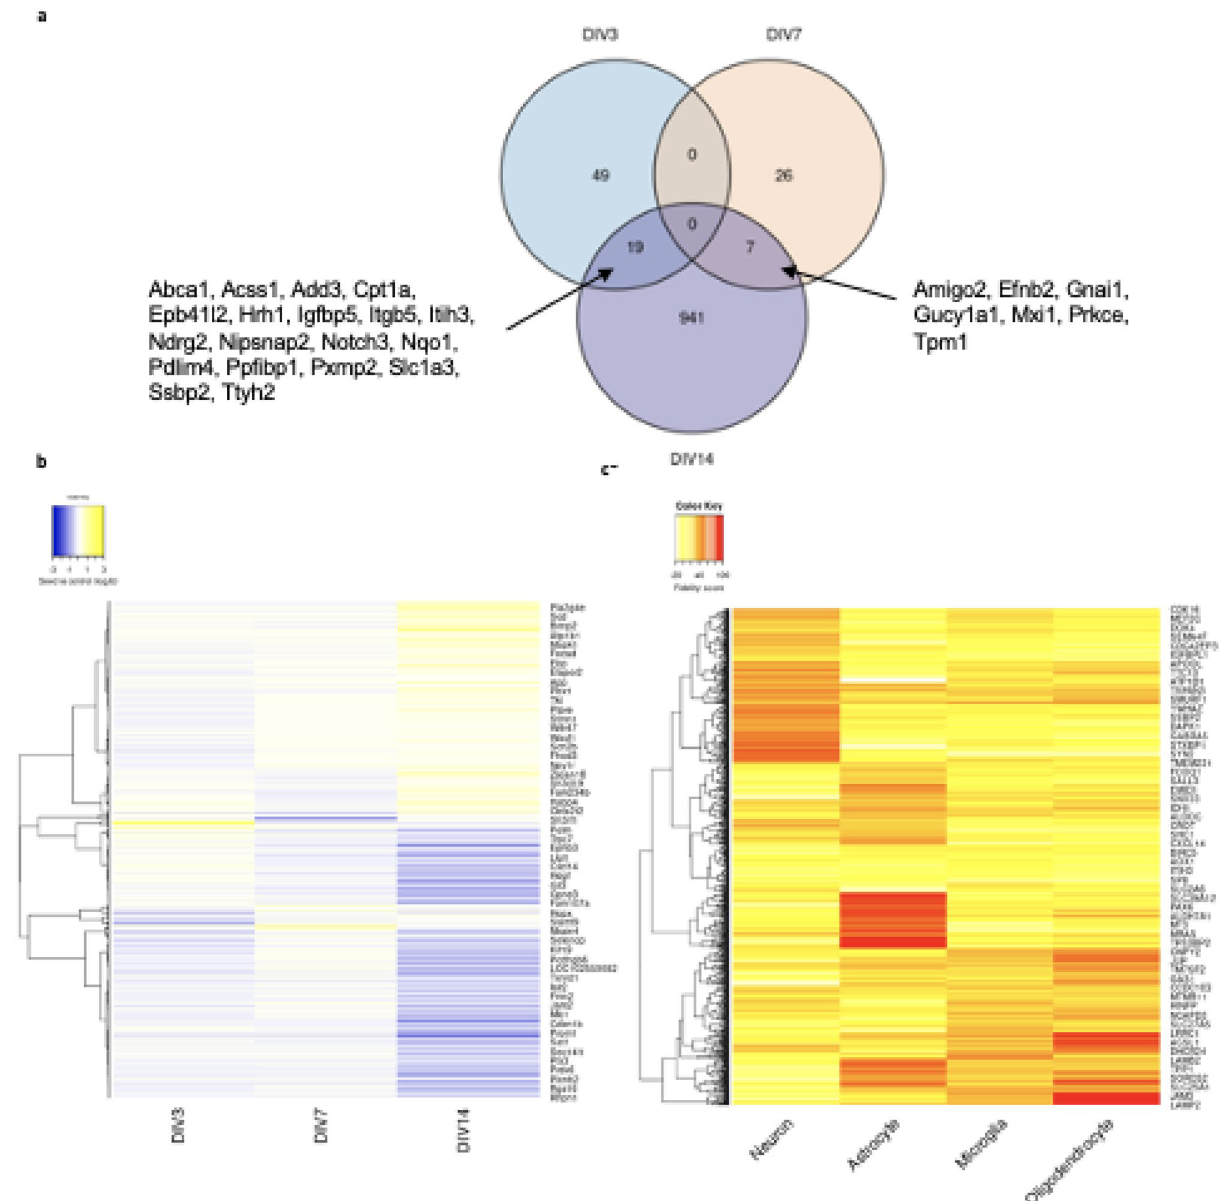
Figure 2. Analysis of the 1075 significantly differentially expressed genes from differential expression analysis. ( a ) Venn diagram showing the overlap of significant genes identified at DIV3, DIV7 and DIV14. ( b ) Heatmap of differentially expressed genes between seed and control at timepoints DIV 3, DIV 7 and DIV 14. Row clustering was applied based on Pearson correlation between genes. Underlying data to generate plot can be found in Supplementary File 2. ( c ) Heatmap of fidelity scores from Cell Type Correlates Oldham Lab 22–24 for cell type specific expression of differentially expressed genes. Row clustering was applied based on Euclidean distance between